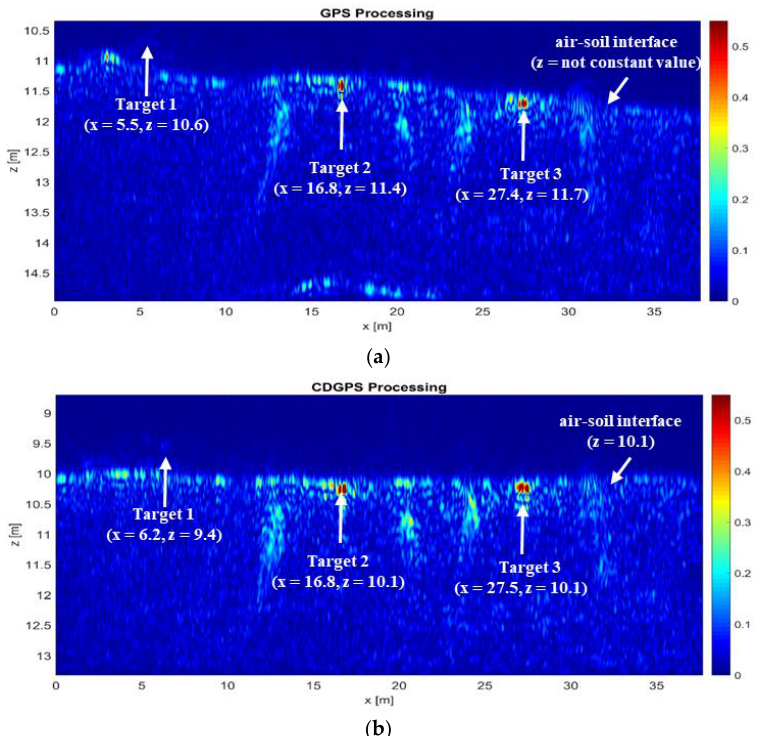
Figure 12. Tomographic images Test 1-Track 2 obtained by Shift and Zoom TSVD algorithm: ( a ) GPS based MoCo; ( b ) CDGPS based MoCo.